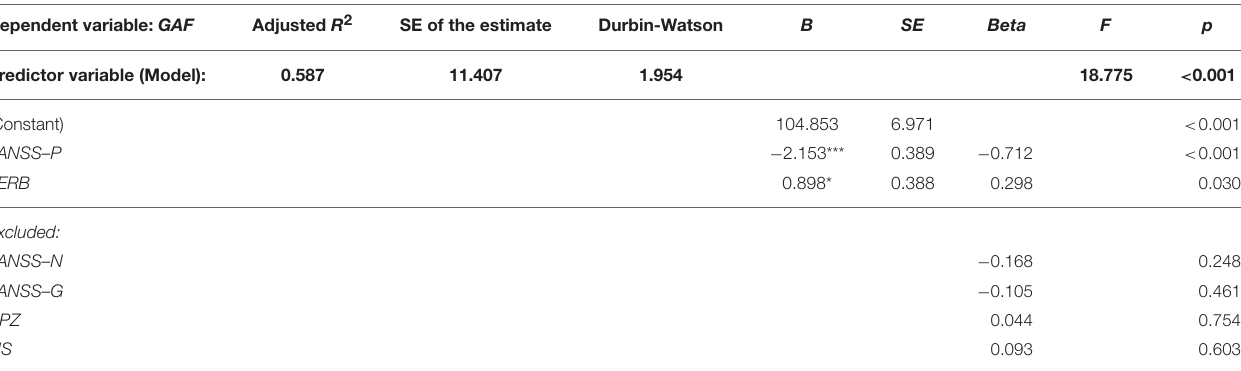
TABLE 5 | Regression model of clinical and neuropsychological variables (predictors) on global functioning measured by GAF (dependent